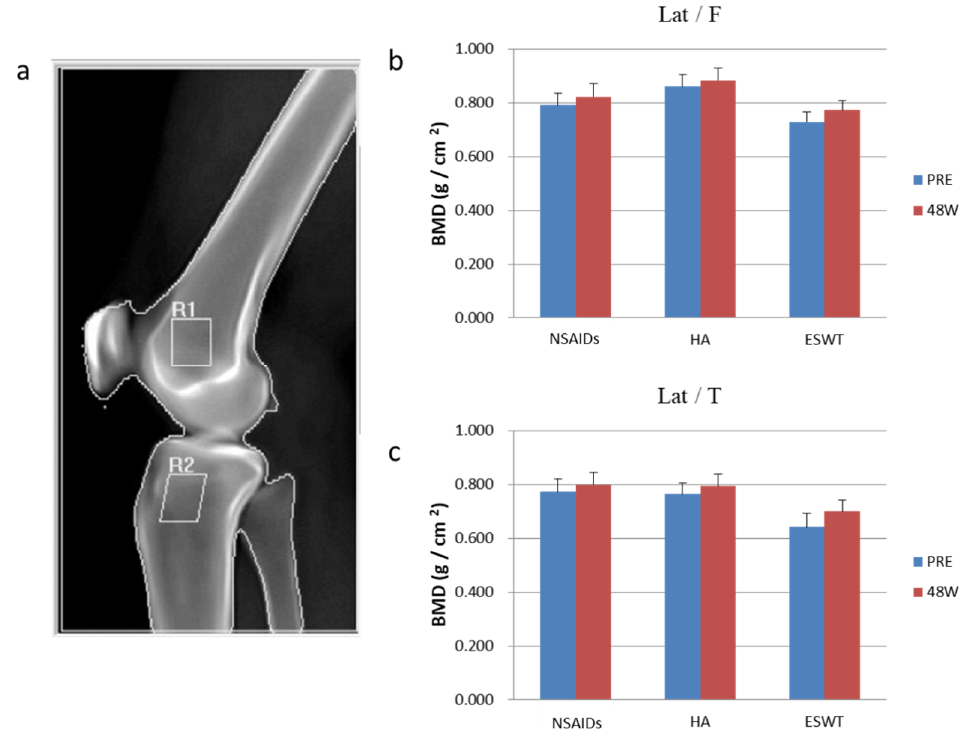
Figure 4. ( a ) The examined region of dual-energy X-ray absorptiometry. ( b ) The bone marrow densitometry of femur of three groups before and after treatment. ( c ) The bone marrow densitometry of tibia of three groups before and after treatment. * p < 0.05 as compared with data before and after treatment one-year follow-up (48 weeks). Lat/F, lateral femur. Lat/T, lateral tibia. BMD, bone mineral density. R1 and R2, region 1 and region 2.